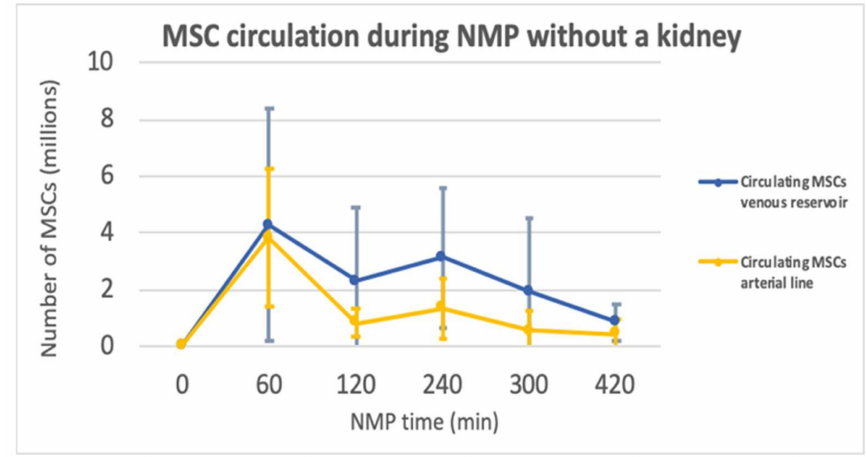
Figure 4. Graph of the MSCs circulating during NMP in the venous reservoir and the arterial line after the addition of 10 million MSCs at t = 60.